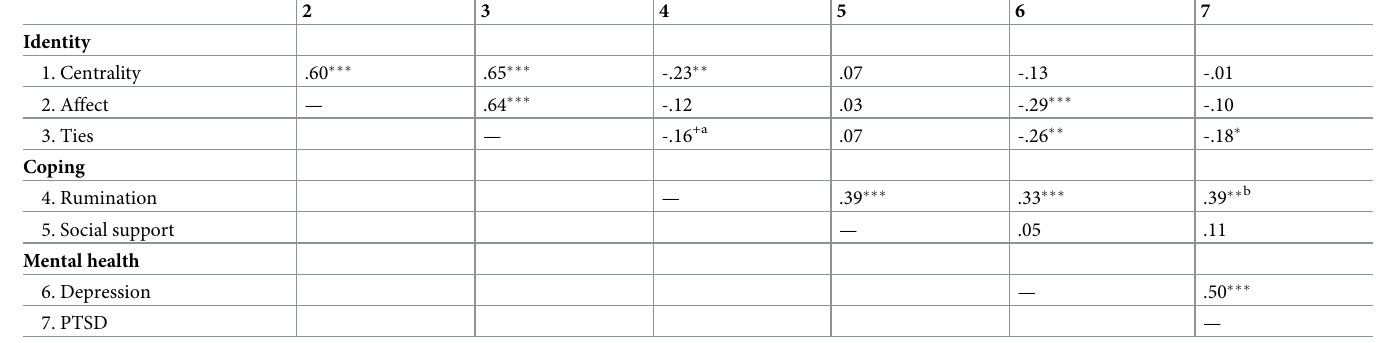
Table 1. Inter-correlations among Study 1